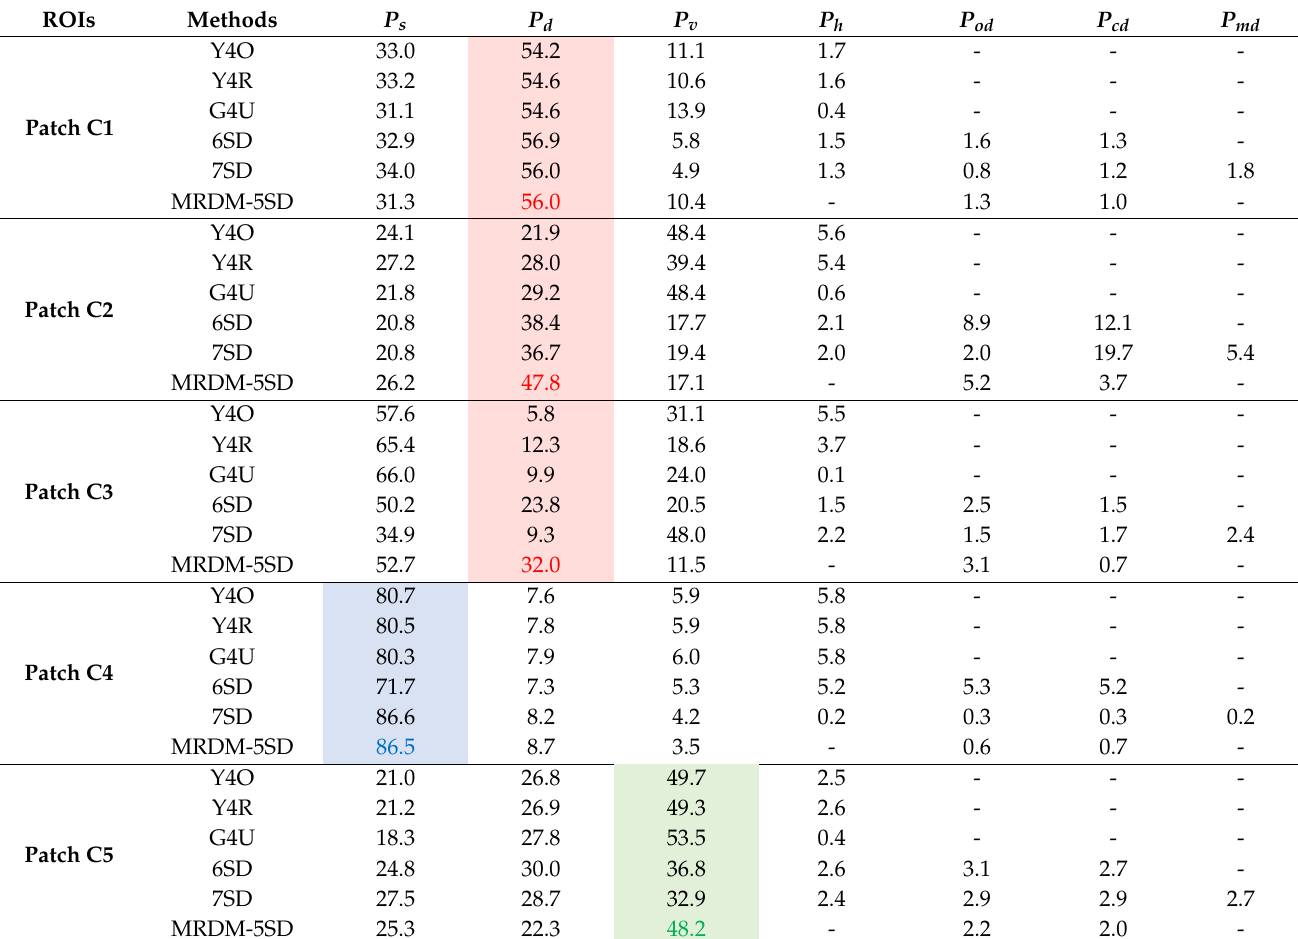
Table 4. Scattering contributions (%) of Patch C1-C5 for E-SAR data sets.